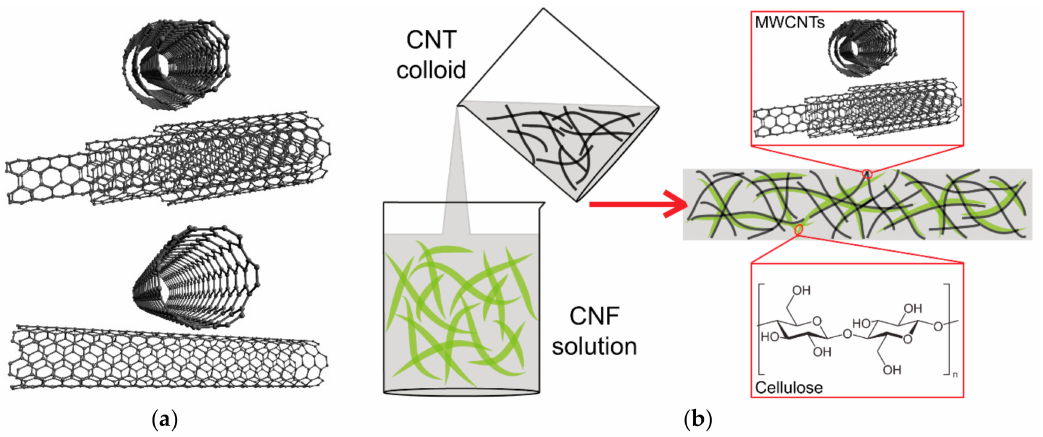
Figure 3. Scheme of multi-walled and single-walled carbon nanotubes ( a ) and of the preparation and structure of nanocellulose / carbon nanotube composites ( b